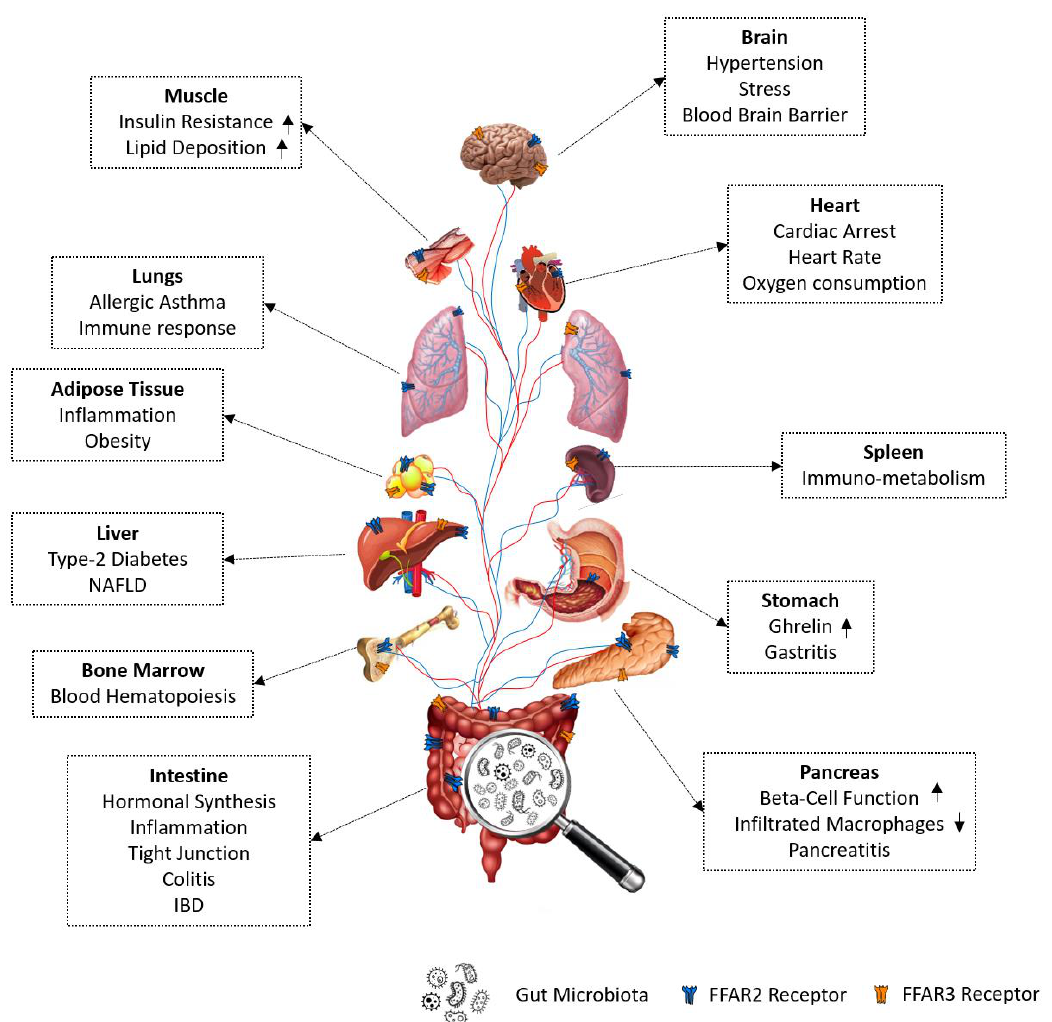
Figure 6. Biological function of FFAR2/3 as short chain fatty acid (SCFA) ’ s receptors at different body parts.